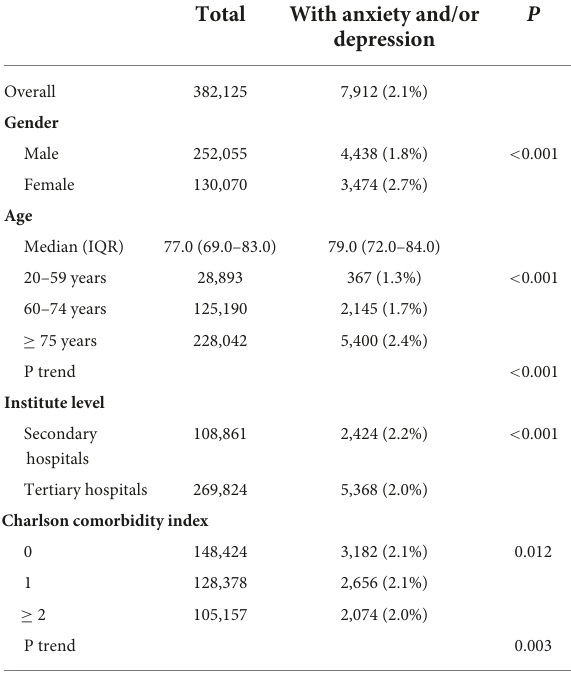
TABLE 1 The characteristics and the prevalence of anxiety and/or depression among patients hospitalized for AECOPD from 2004 to 2020 in Beijing,